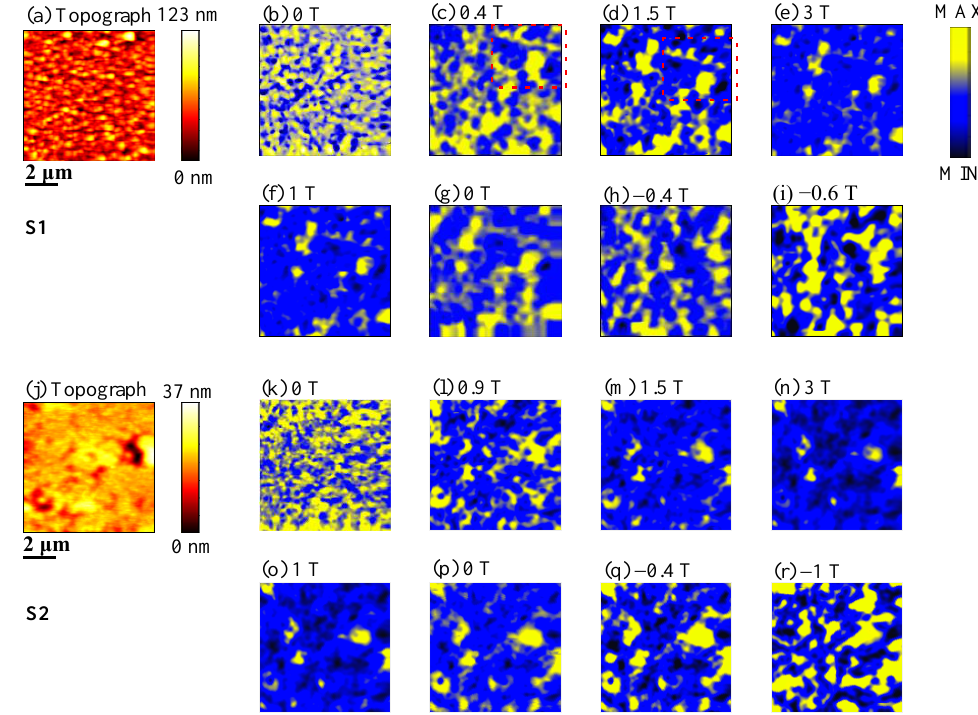
Figure 5. MFM images during the initial magnetization and the demagnetization process: ( a ) AFM topography of the S1 sample; ( b – i ) MFM images for the S1 sample; ( j ) AFM topography of the S2 sample; ( k – r ) MFM images of the S2 sample. All MFM images are obtained from the same area, which is consistent with the topography region.